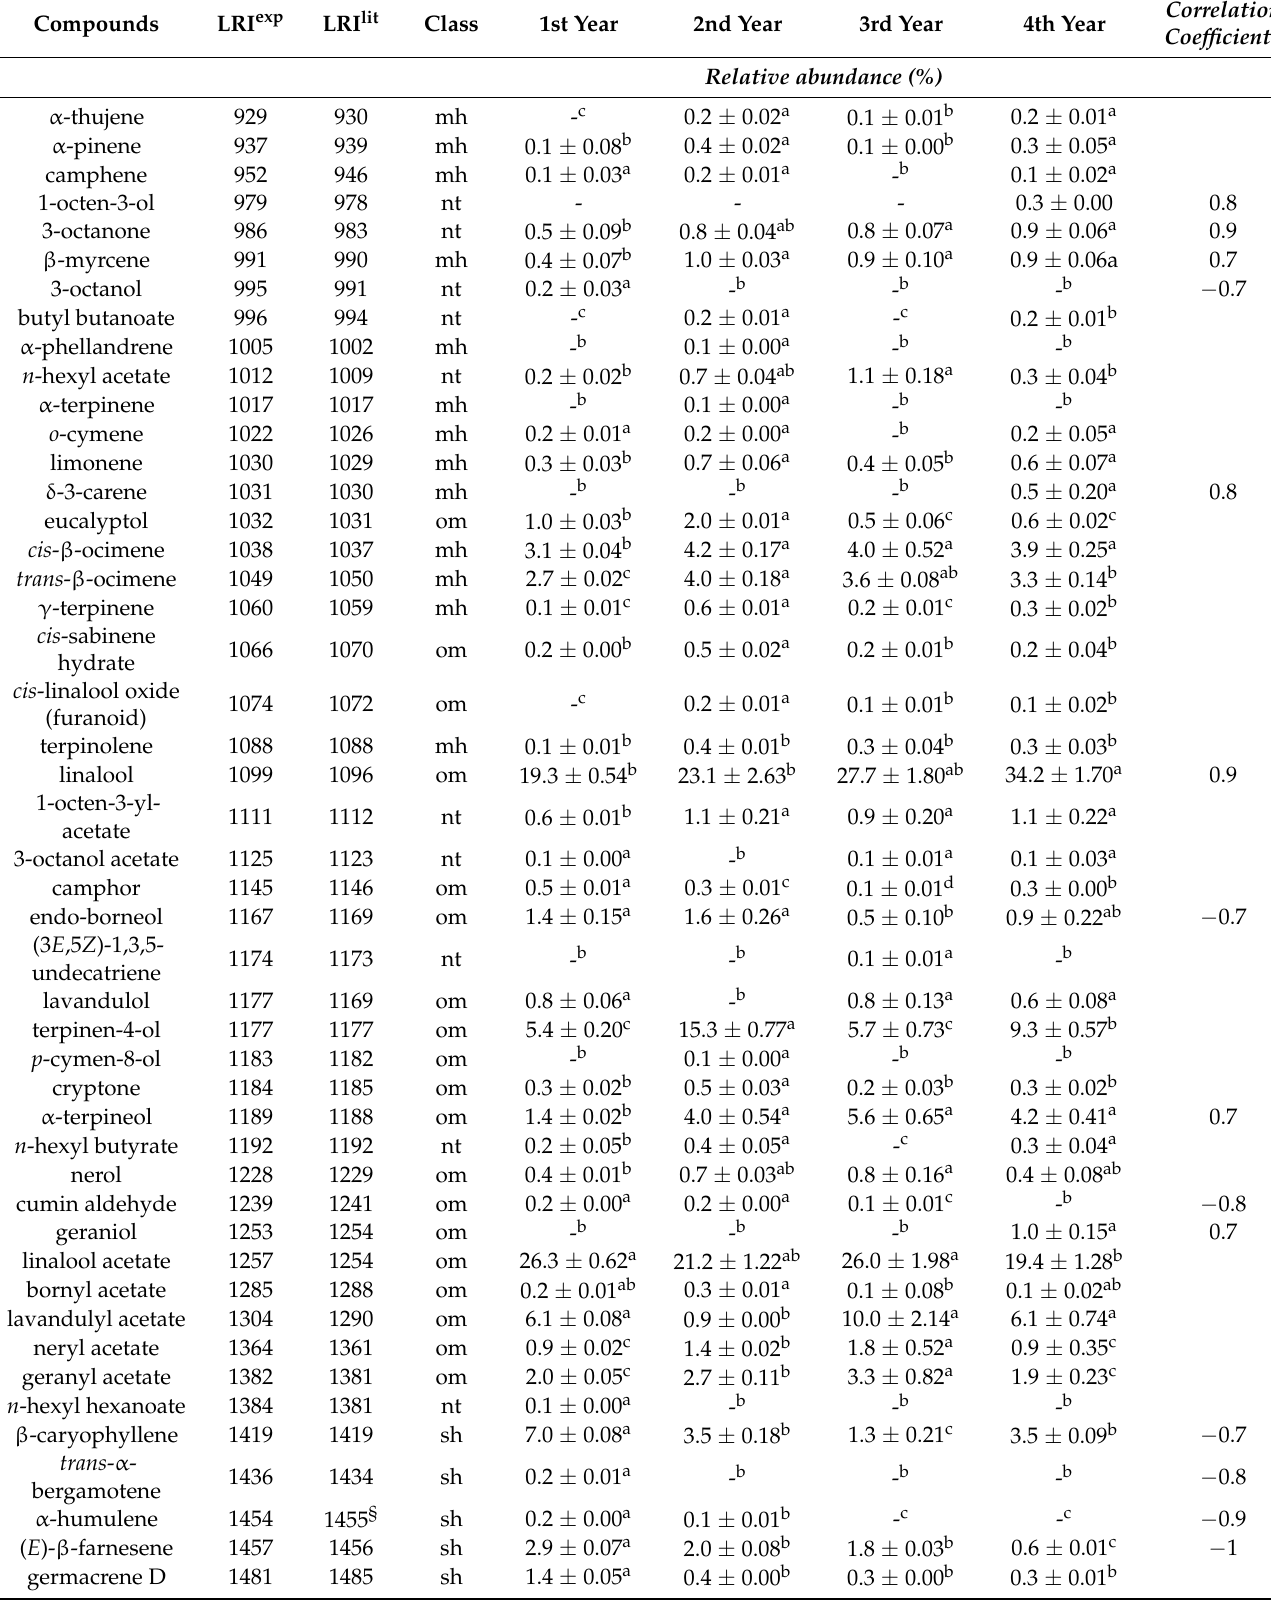
Table 1. Essential oil composition of Lavandula angustifolia during the four years of growth and collection (mean ±